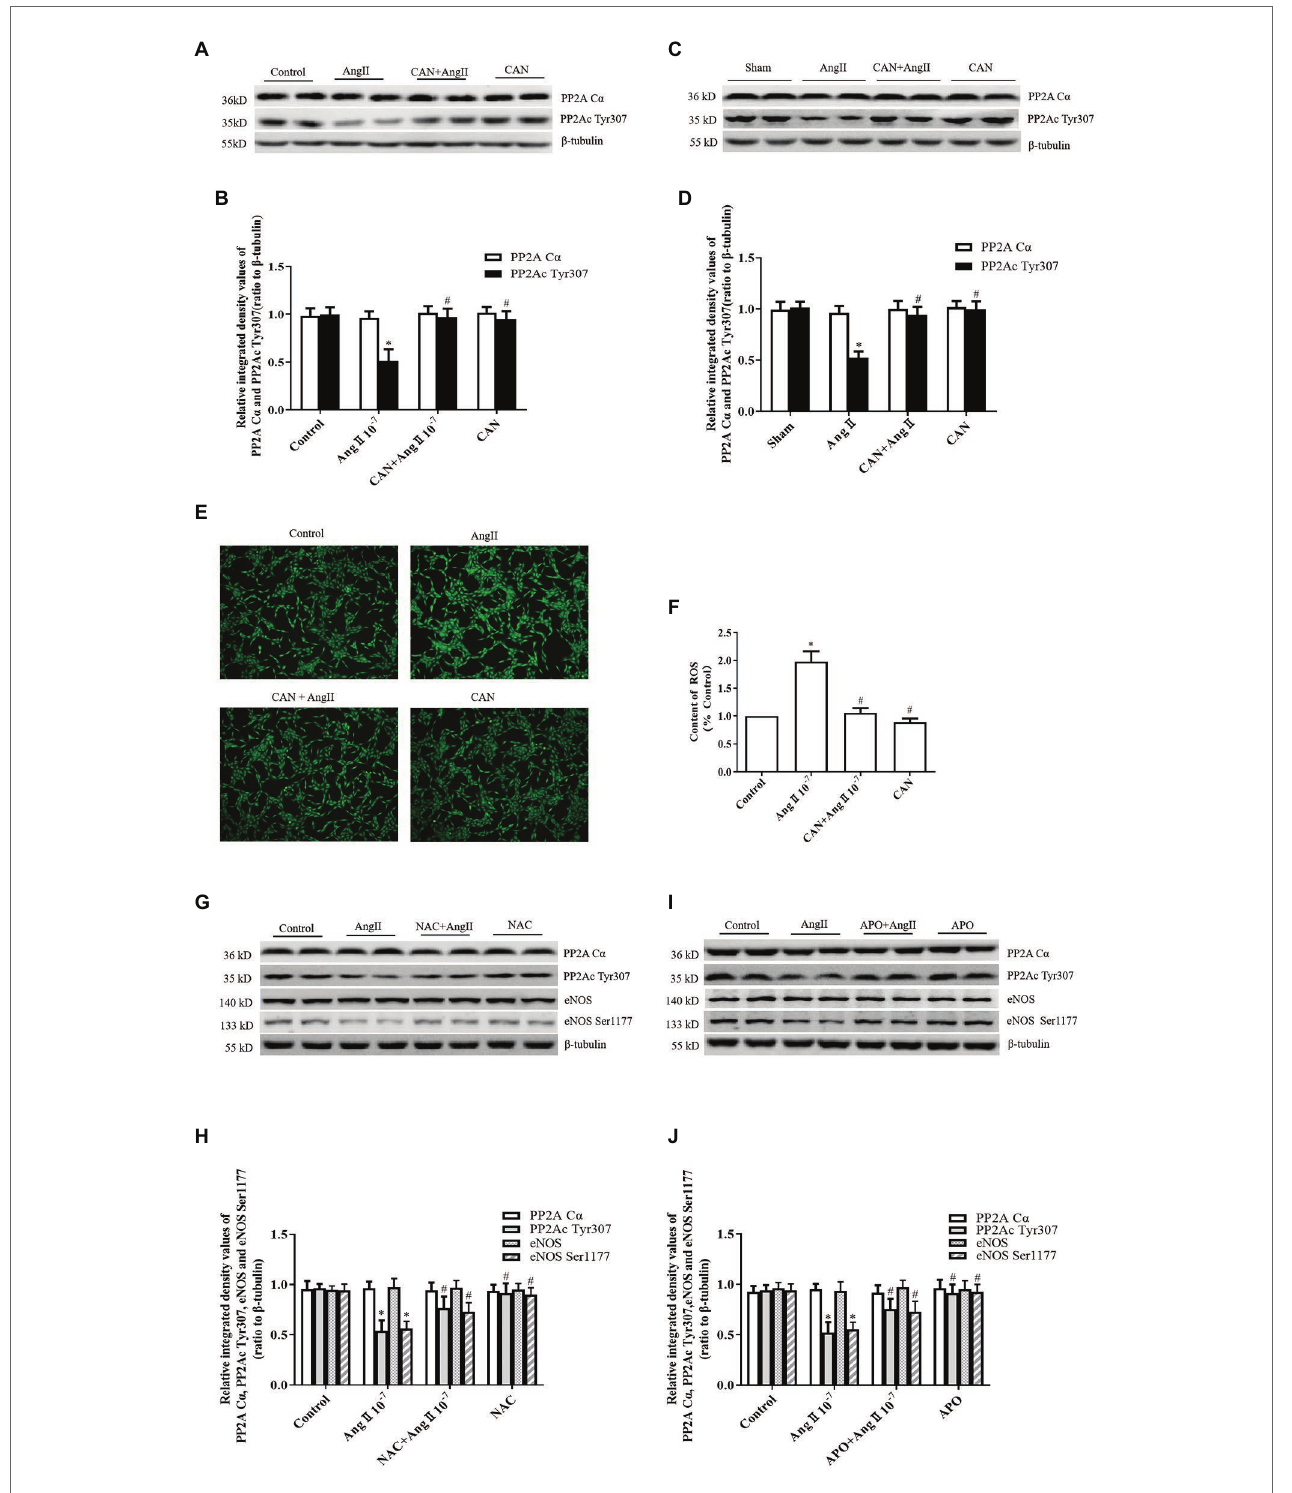
FIGURE 3 | AngII/AT 1 R pathway downregulates PP2Ac Tyr307 phosphorylation, which is related with ROS generation. (A,B) CAN blocked AngII-mediated downregulation of PP2Ac Tyr307 phosphorylation in HUVECs. HUVECs were pretreated with 10 −6 M CAN for 3 h or not, then stimulated with 10 −7 M AngII for 12 h ( n = 6 independent experiments). (C,D) CAN blocked AngII-mediated downregulation of PP2Ac Tyr307 phosphorylation in rat mesenteric arteries ( n = 6 rats per